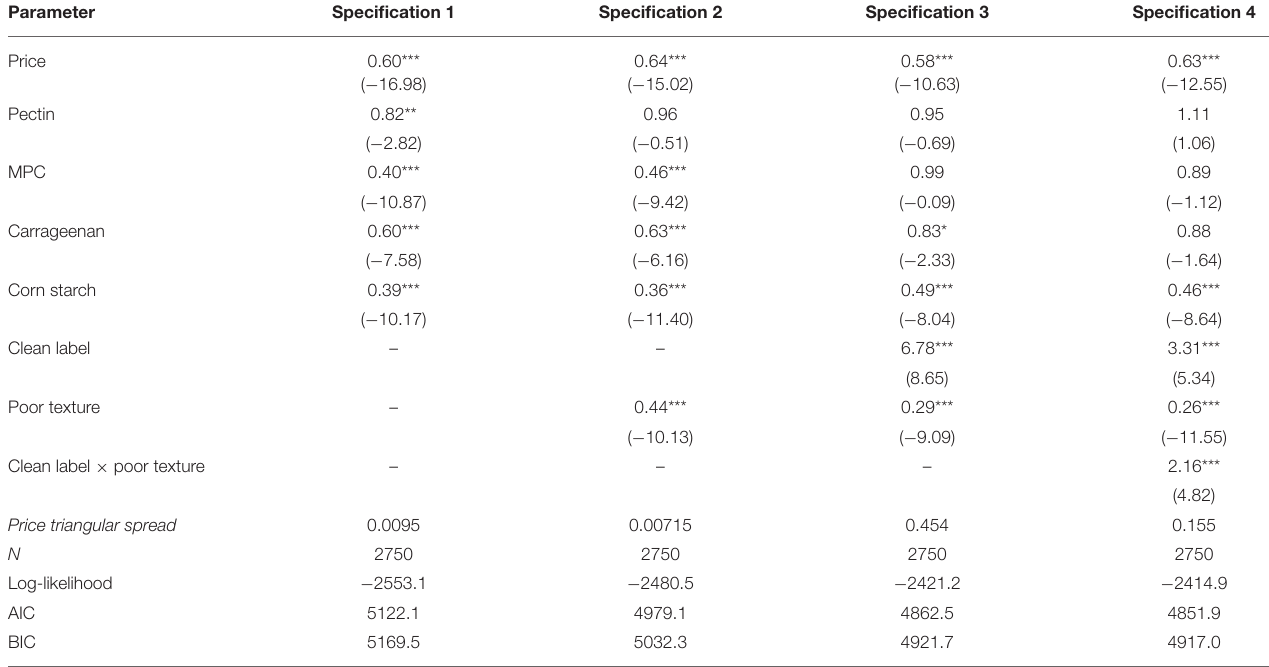
TABLE 3 | Alternative specific mixed logit model specifications, results with odds ratios.